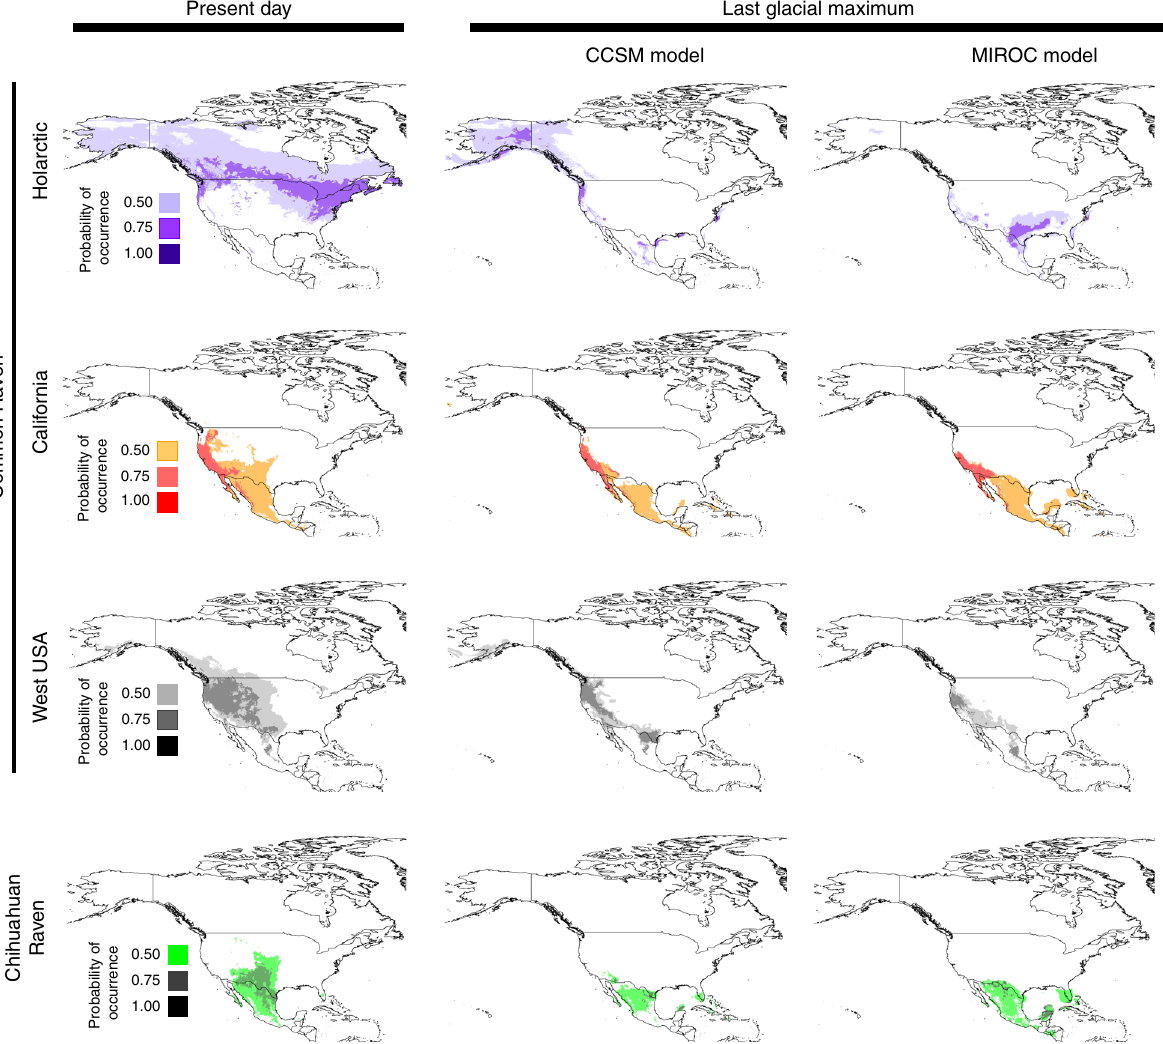
Fig. 6 Suitable climatic niches for North American raven lineages under present-day and Pleistocene LGM (18 – 21 kya) climatic conditions. ENMs predict overlap in suitable climatic niches in western United States, Mexico and Central America for Holarctic, California and Chihuahuan Raven lineages during the LGM under both MIROC and CCSM paleo-climate models. Colours correspond to the predicted relative climatic suitability for each lineage in North America (see inset for key to probability of occurrence). Regions with probability of occurrence above 0.4 are considered typical of the abiotic niche of the species. Test AUC scores for each model followed by the maximum possible AUC score in brackets and the standard deviations are as follows: California: 0.77 (0.78) ± 0.003; Holarctic: 0.64 (0.64) ± 0.003; admixed west USA: 0.71 (0.72) ± 0.003; Chihuahuan Ravens: 0.88 (0.88) ± 0.003. See Supplementary Fig. 5 for ENMs based on different regional subsets and for collection localities used in ENMs for each